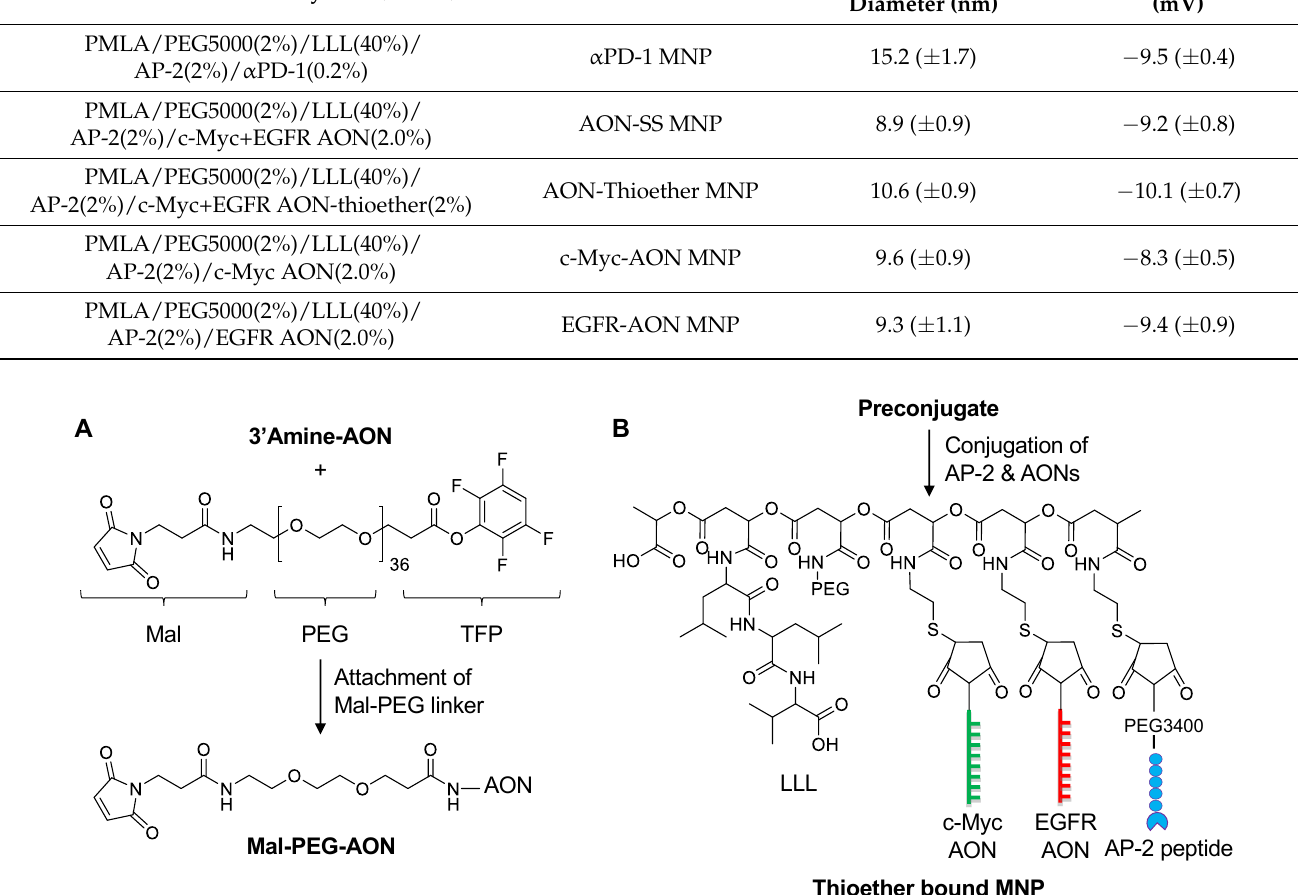
Table 1. Summary of MNPs, their abbreviations, and physicochemical characterization. Multifunctional Nano Polymers (MNPs)